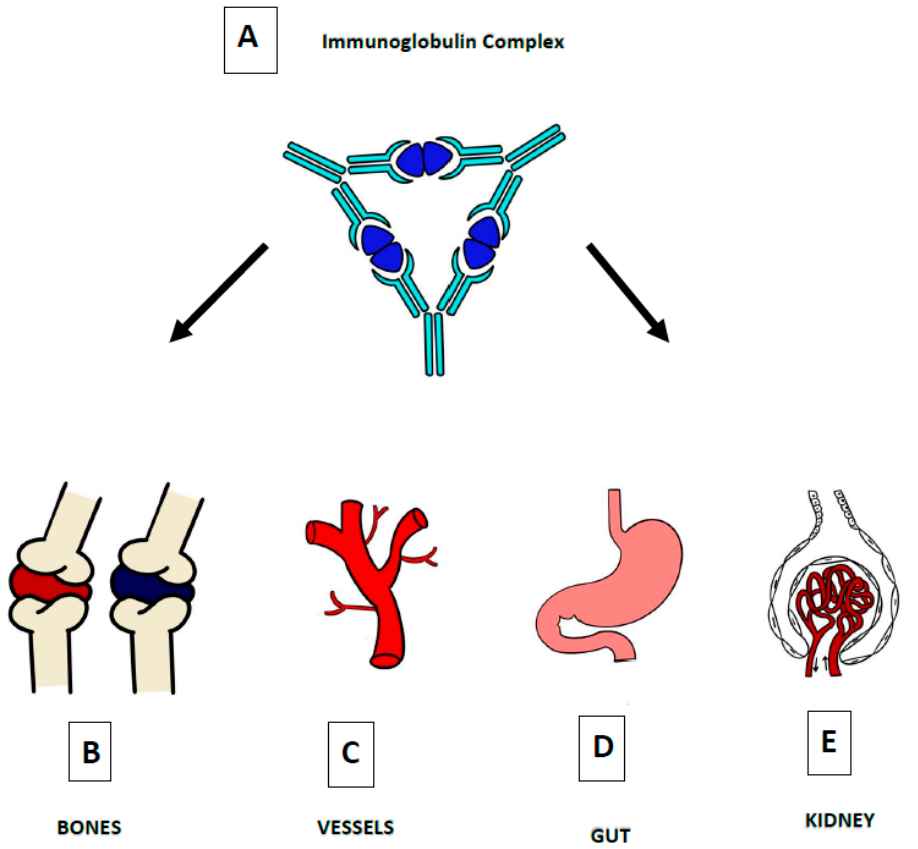
Figure 4. The defining pathogenic mechanism of HSP is due to IgA-containing immune complexes ( A ), which deposit in the small vessels of skin ( C ), joints ( B ), intestine ( D ), and kidneys ( E ).